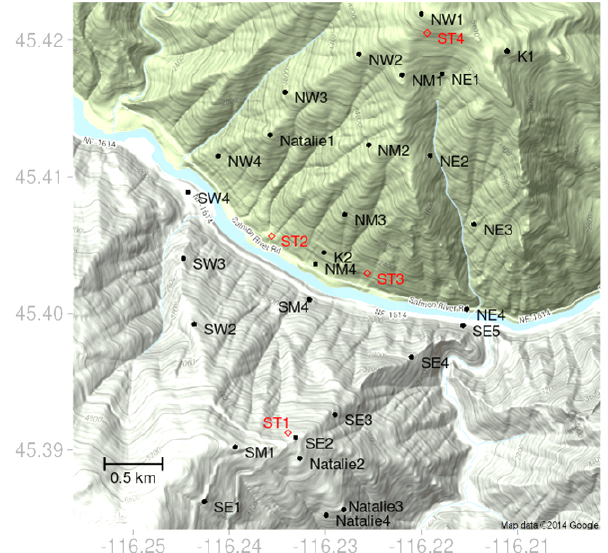
Figure 3. Sensor layout at the Salmon River Canyon. Black circles indicate surface sensors. Red diamonds indicate sonic anemome- ters, weather stations, and vertical profiling